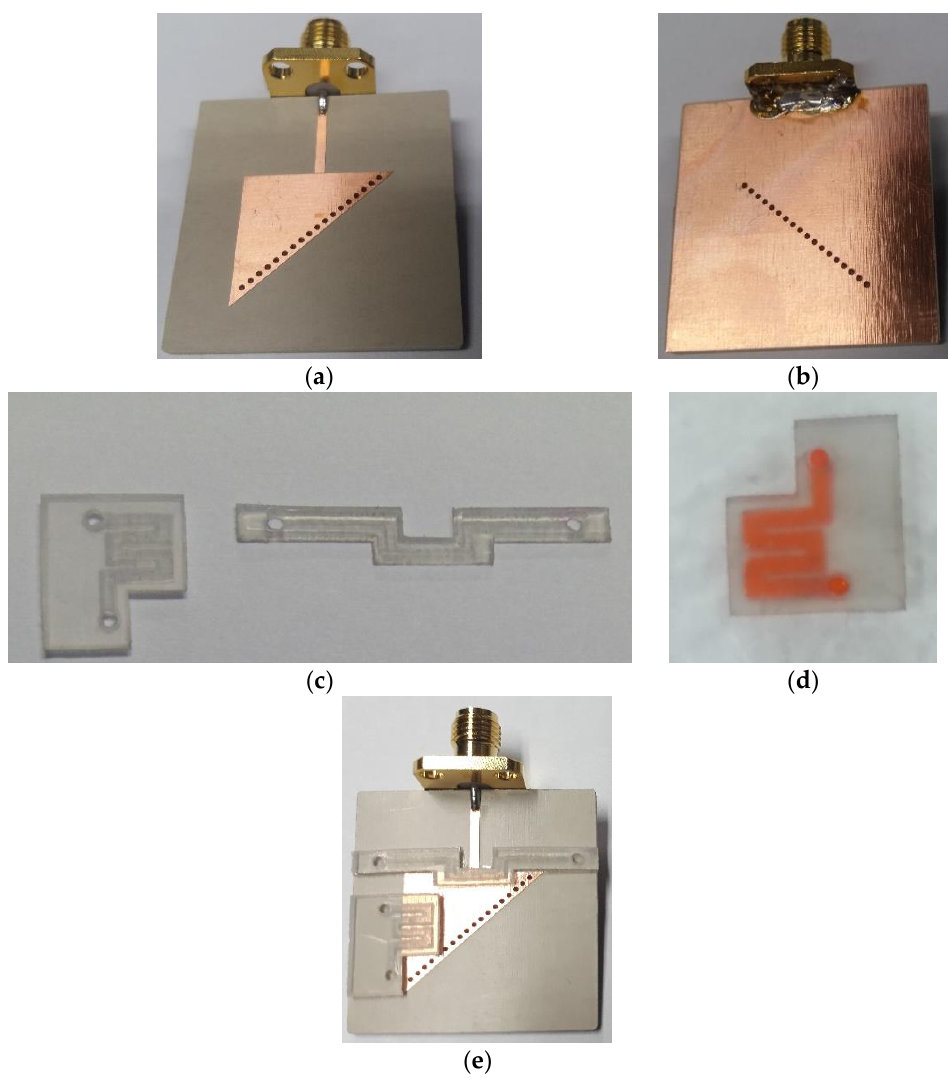
Figure 11. ( a ) Fabricated prototype integrated with microfluidic channels. ( a , b ) Top/bottom views of the fabricated prototype. ( c ) Both the channels realized using a laser cutting machine. ( d ) Testing of the channels by injecting colored water for verification (only Ch 2 is shown). ( e ) Fabricated prototype resonator integrated with microfluidic channels.